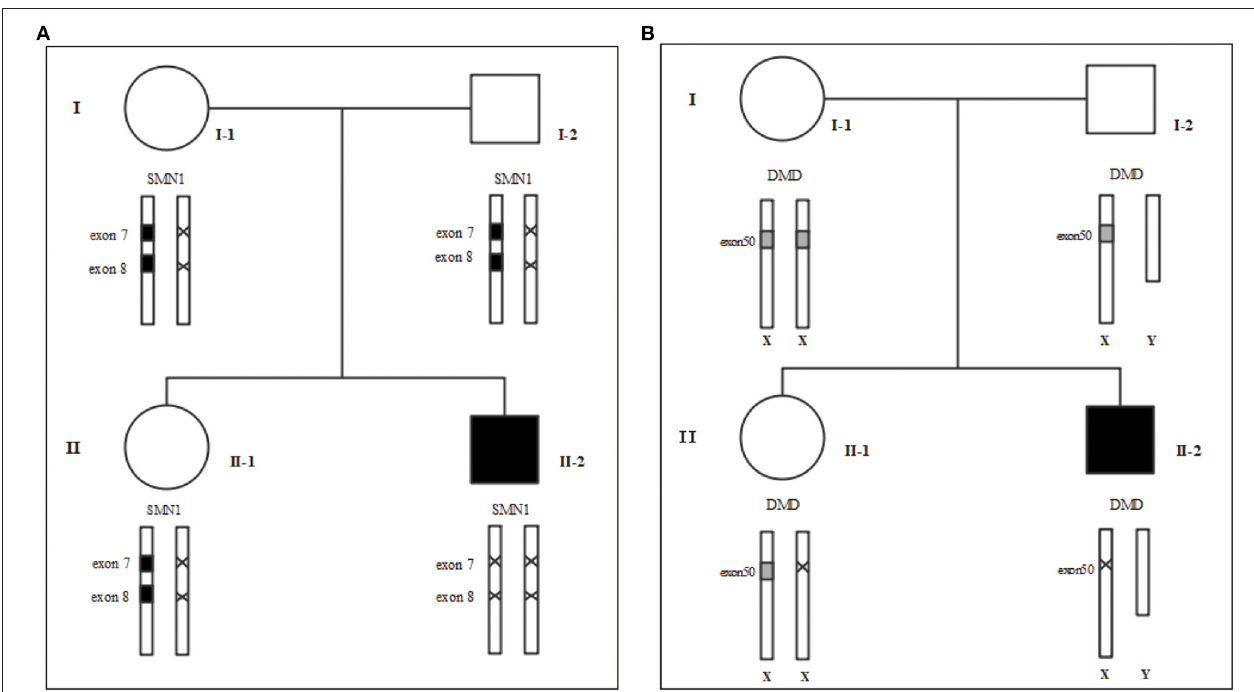
FIGURE 1 | Family tree. (A) MLPA for SMA (B) MLPA for DMD. We use “ × ” to indicate the deletion. I-1: Mother’s gene report showed only one copy in exons 7 and 8 of SMN1, and there was no deletion or duplication of the DMD gene; I-2: Father’s gene report showed that SMN1 in exon 7 and exon 8 had heterozygous deletions; II-1: the 2-year-old sister’s gene report showed only one copy of SMN1 in exons 7 and 8 and a heterozygous deletion in exon 50 of the DMD gene; II-2: The patient’s gene report showed homozygous deletions of SMN1 in exon 7 and exon 8, and a homozygous deletion in exon 50 of the DMD